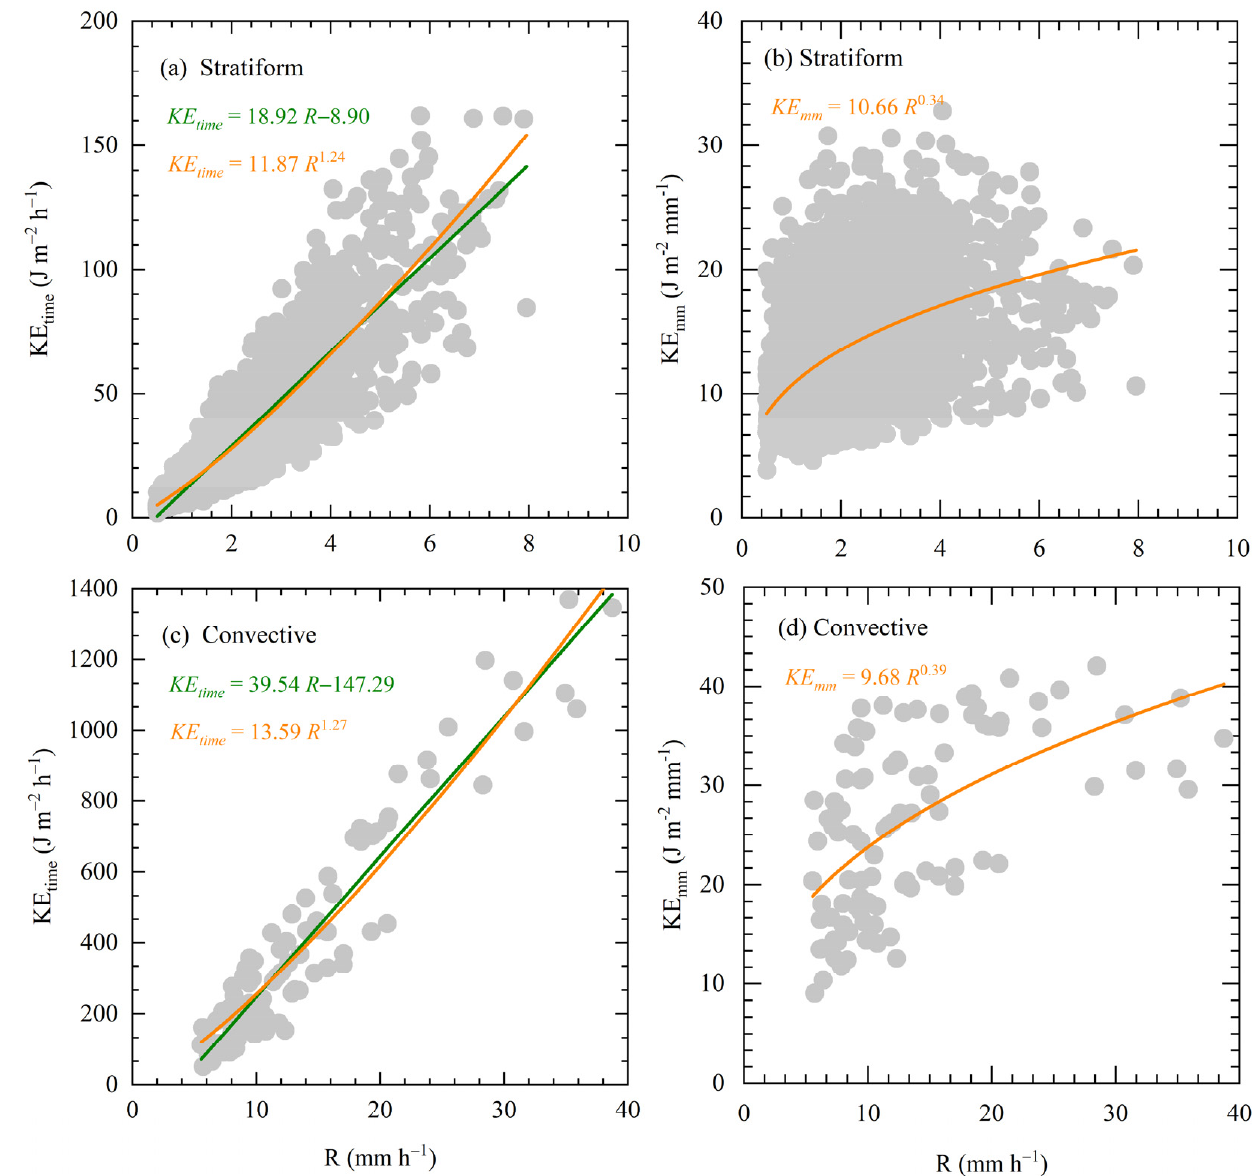
Figure 13. Scatterplots of KE time vs. R and KE mm vs. R , and the fitted KE time – R and KE mm – R relations for ( a , b ) stratiform and ( c , d ) convective rainfall in Zhaosu.